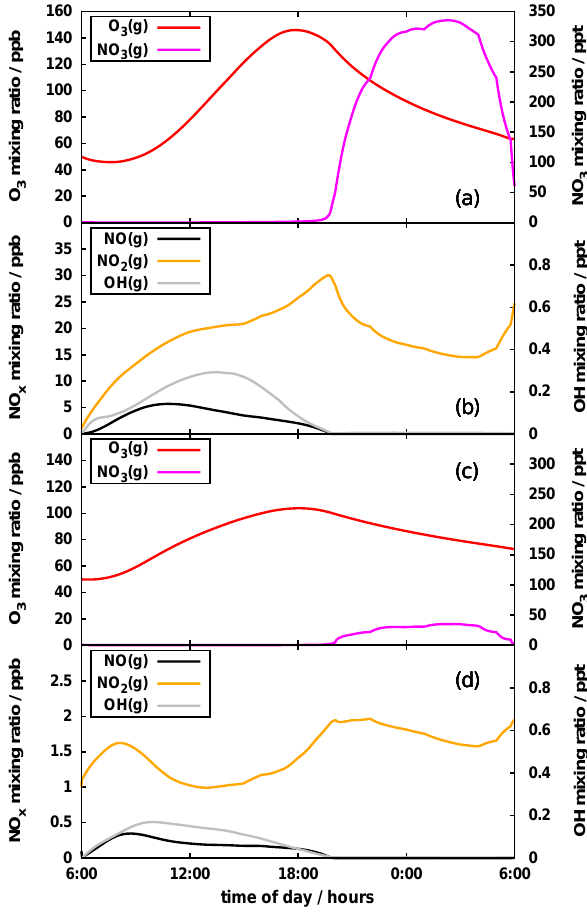
Fig. 2. Evolution of gas concentrations in an urban polluted envi- ronment during the simulated 24h period. Panel (a) and (b) rep- resent scenario A with high water vapour concentration and high NO x emissions. Panel (c) and (d) represent scenario D with low water vapour concentration and low NO x emissions. Note the dif- ferent scales on the vertical